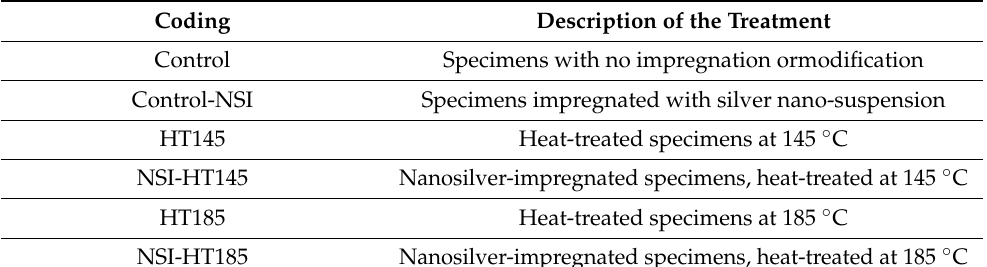
Table 2. Description of the coding system of different treatments performed in this research work. Coding